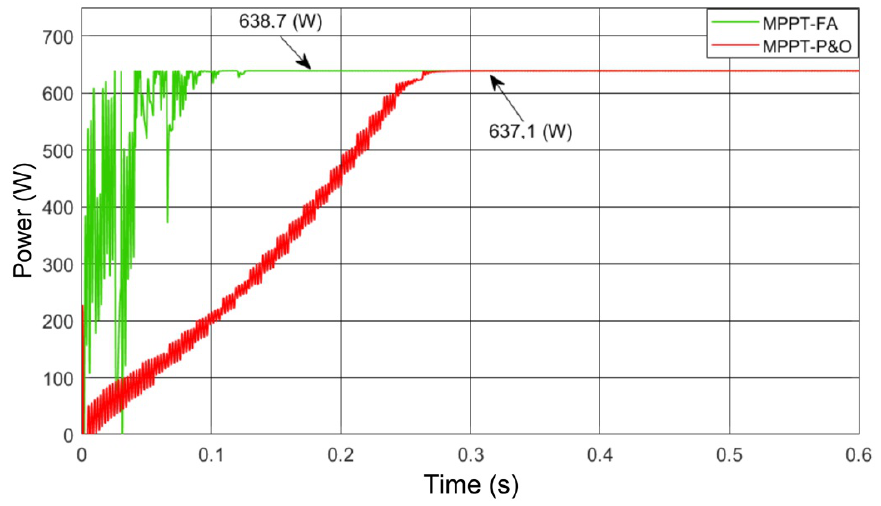
Figure 10. Simulation results Step 1: P&O output power (637.10 W), FA output power (638.7